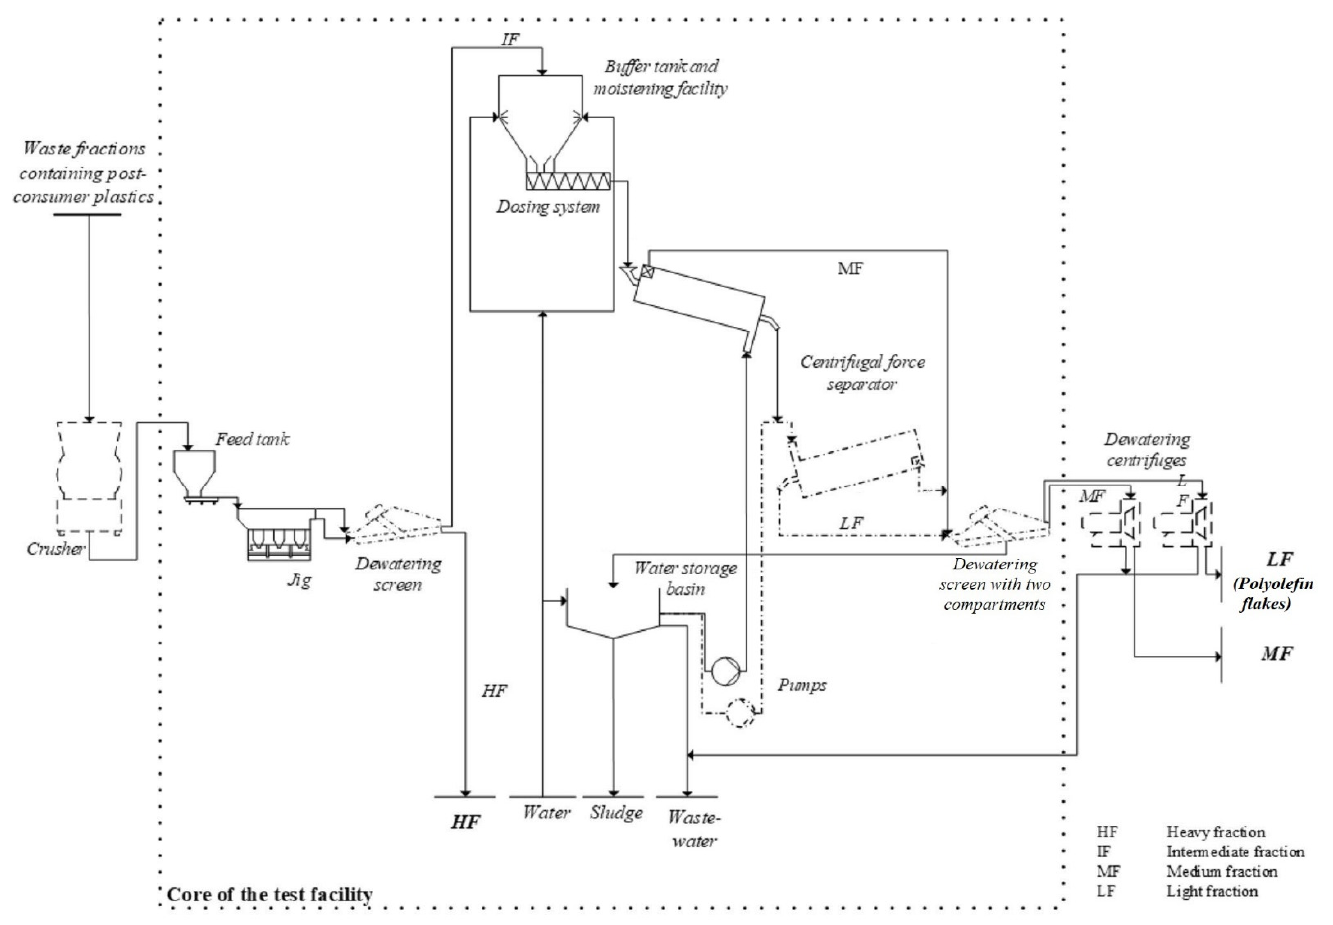
Figure 4. Flowchart of the lab-scale plant [14].